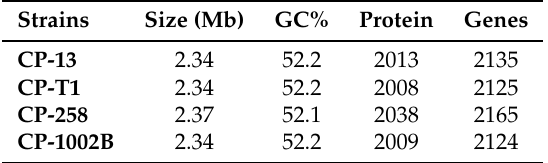
Table 1. Replicon information summary of each C. pseudotuberculosis strain.